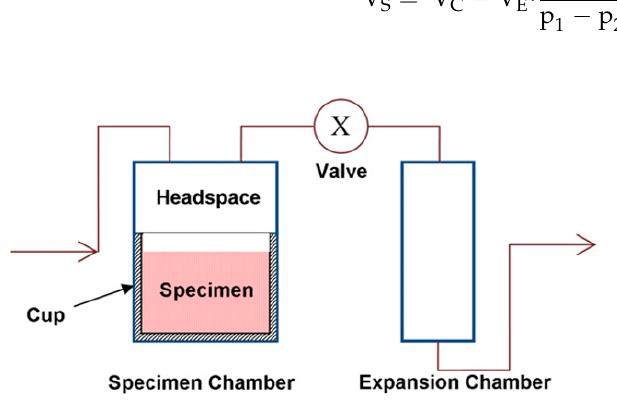
Figure 4. Schematic set-up of a gas pycnometer. Reprinted from reference [26] with permission from Elsevier.